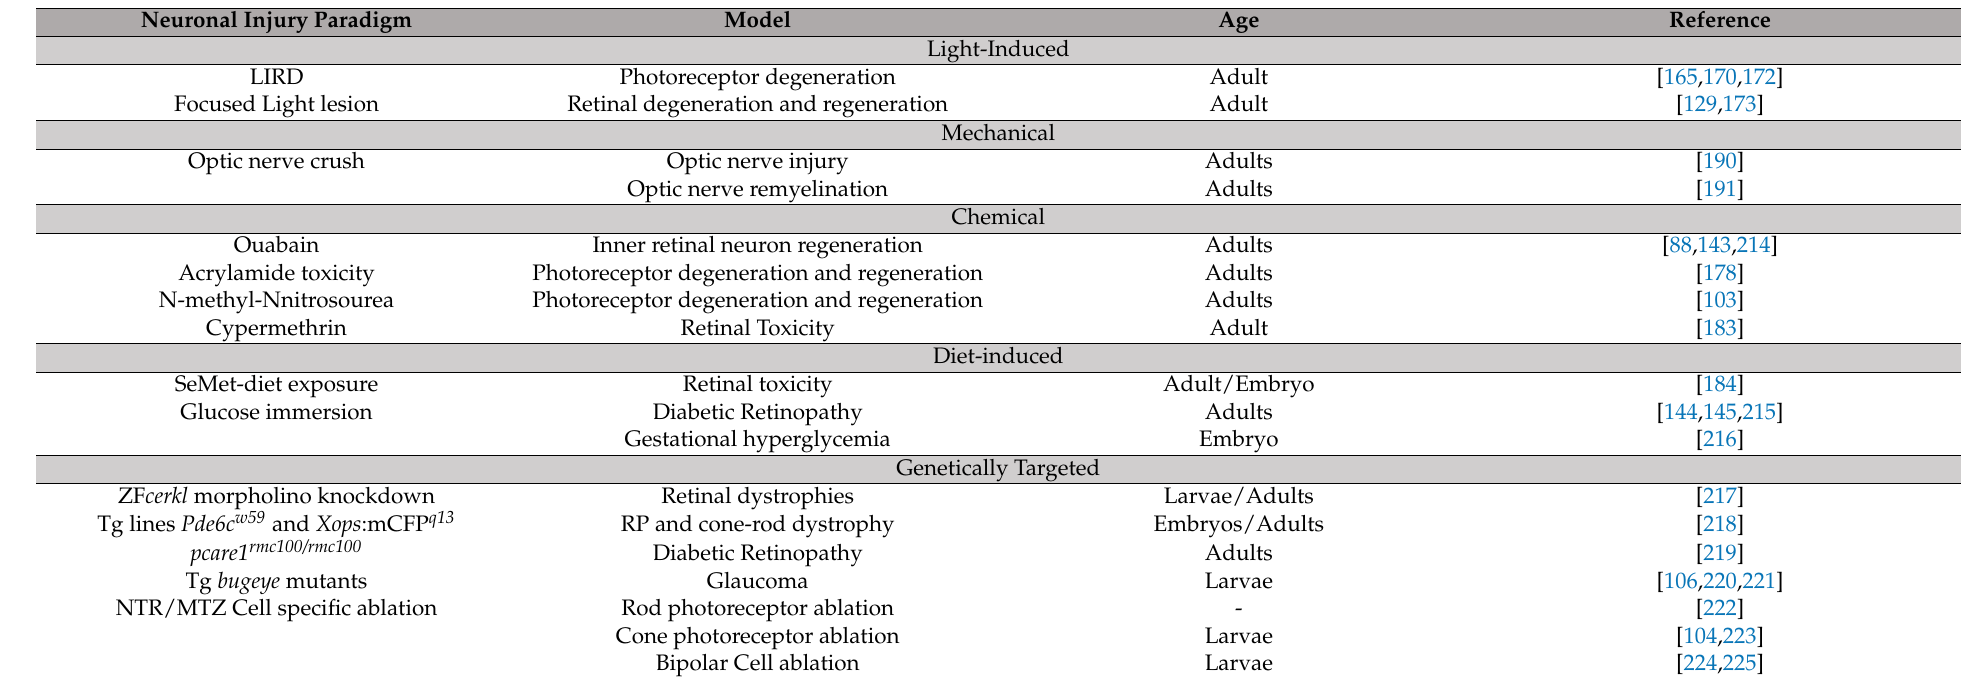
Table 3. Studies characterizing retinal neurodegeneration and/or regeneration in zebrafish retinal injury